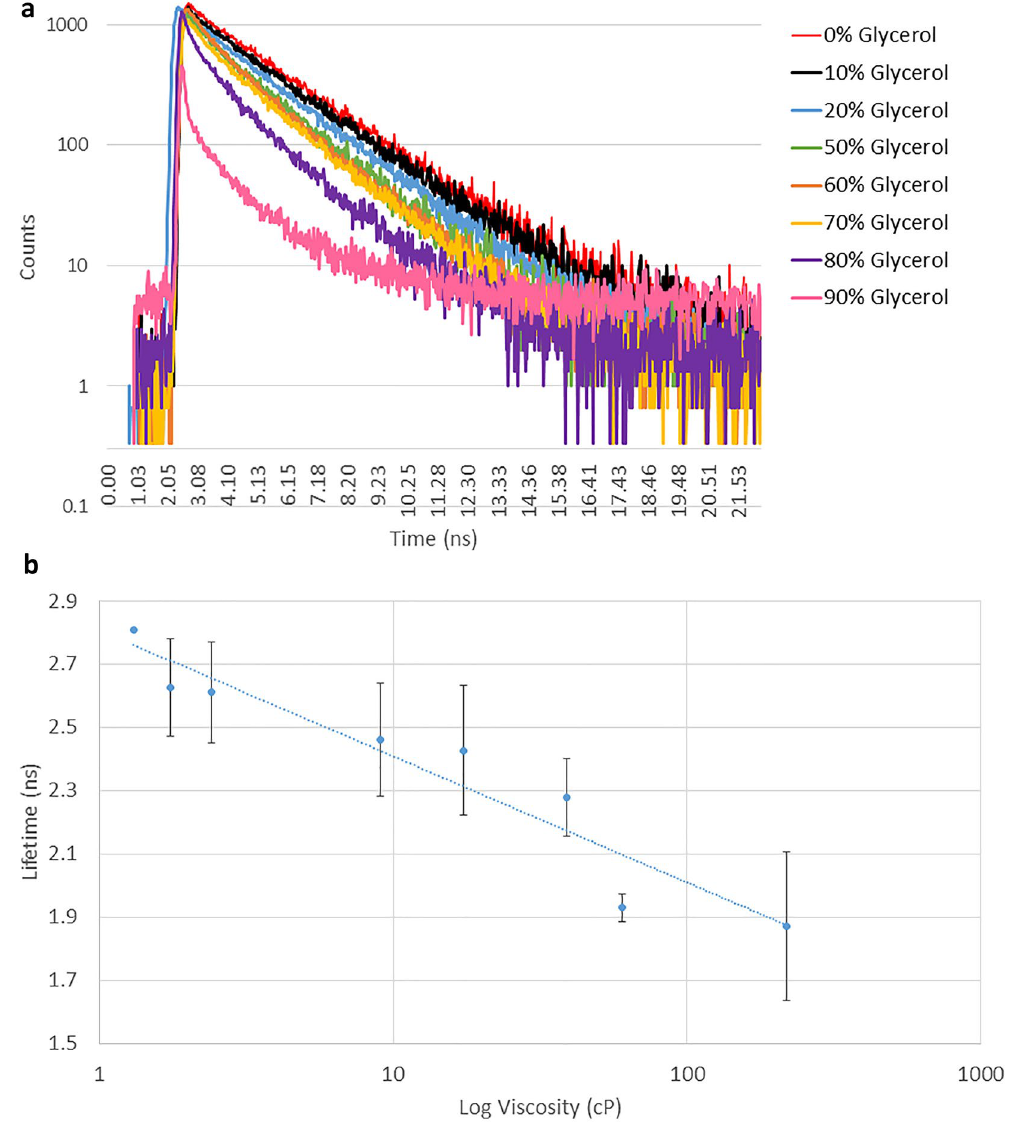
Figure 2. ( a ) Viscosity dependence of 0.25 µg/ml GFP fluorescence lifetime in solution at various glycerol concentrations. Semi-logarithmic plot of the fluorescence lifetime as a function of glycerol/water ratio. The fluorescence decay data shown are representative of three measurements. ( b ) Viscosity sensitivity of GFP with fluorescence lifetime displayed as centipoise (cP) in varying glycerol / water concentration. Standard deviation plotted as error